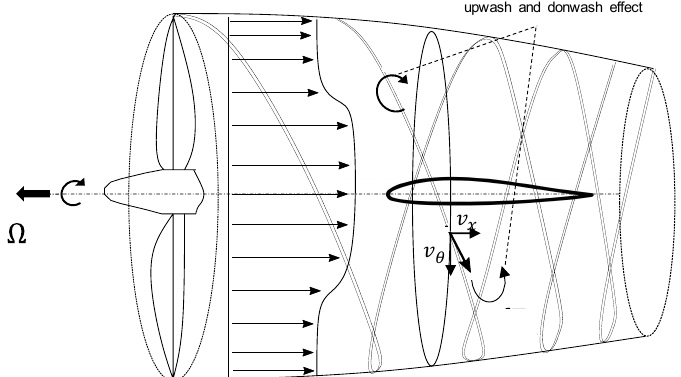
Figure 1. Schematic of a wing-tip (tractor) propeller and downstream effects on